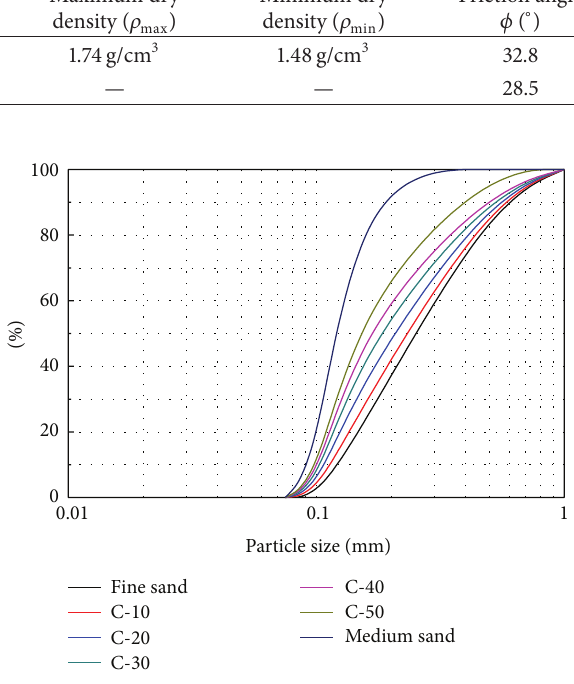
Figure 2: Grain size